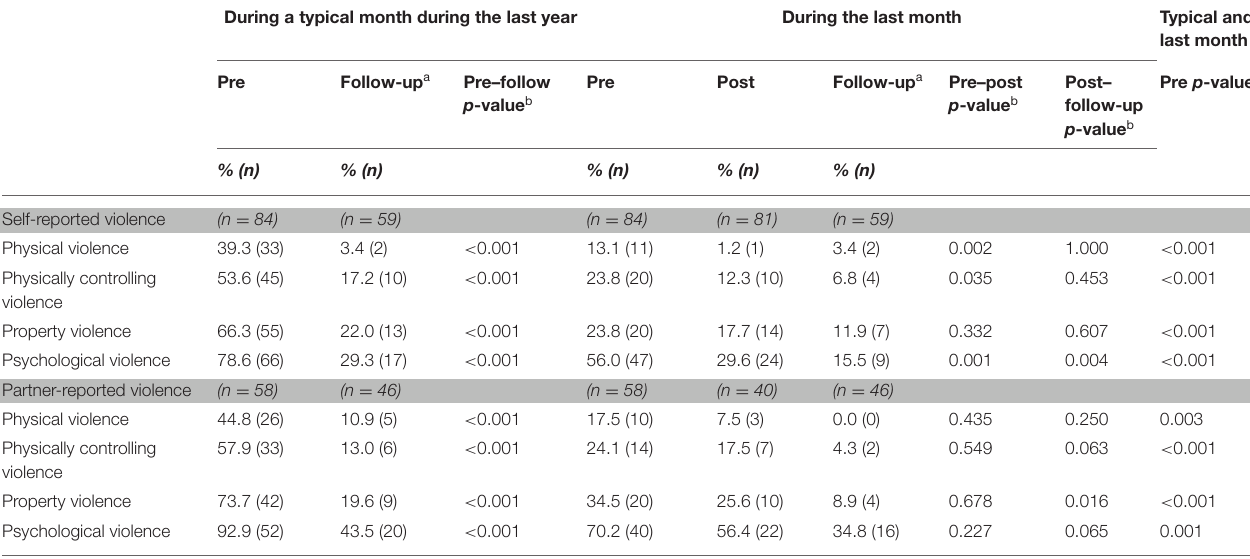
TABLE 1 | Proportions ( n ) of men self-reporting at least one incidence of male to female partner violence, and partner-reports of at least one incidence of male to female partner violence. During a typical month during the last year During the last month Typical and last month Post– Post Follow-up a Pre–post Pre Follow-up a Pre–follow p -value b p -value b